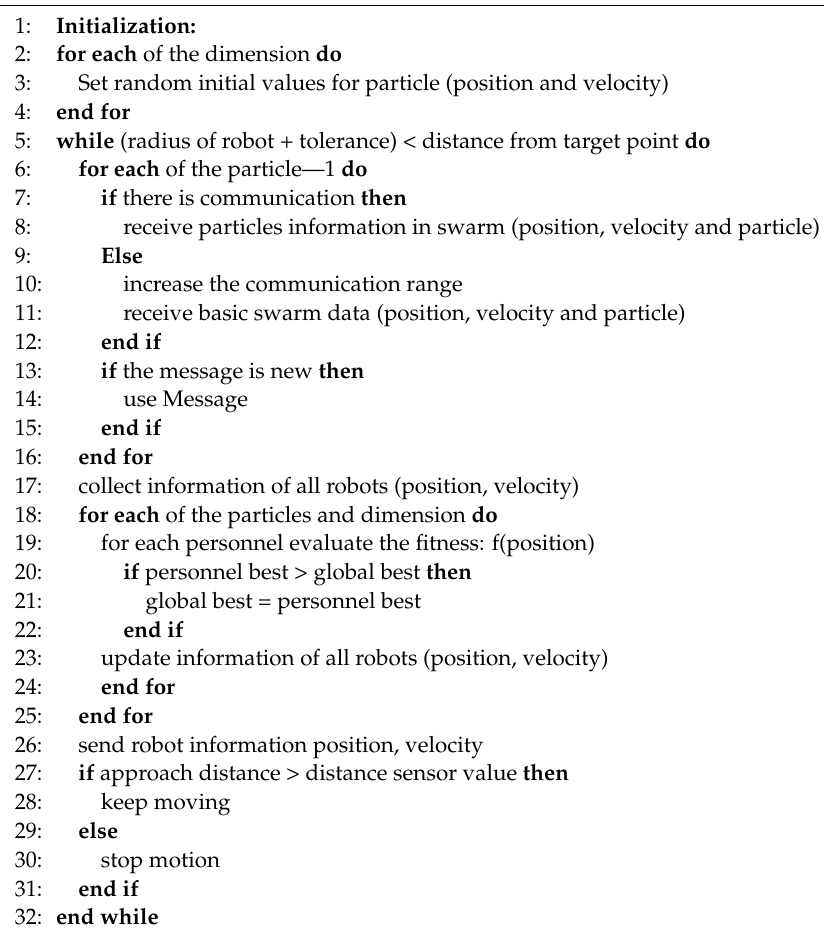
Algorithm 8 General